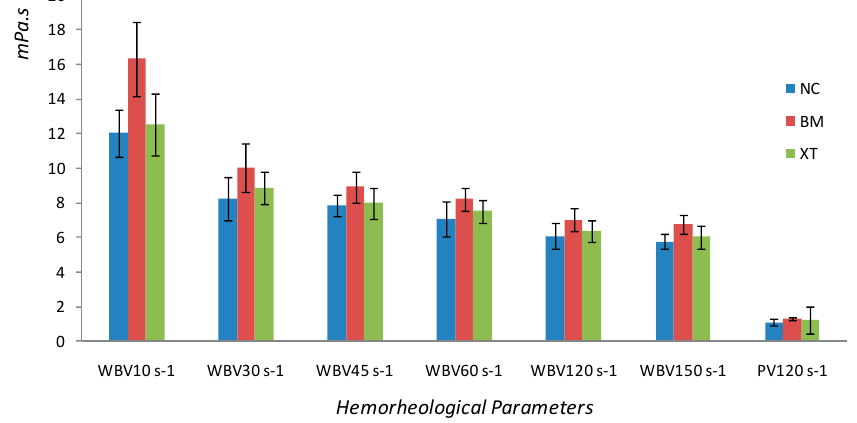
Figure 1. Effects of XXT on whole blood and plasma viscosity in rats with BBS.